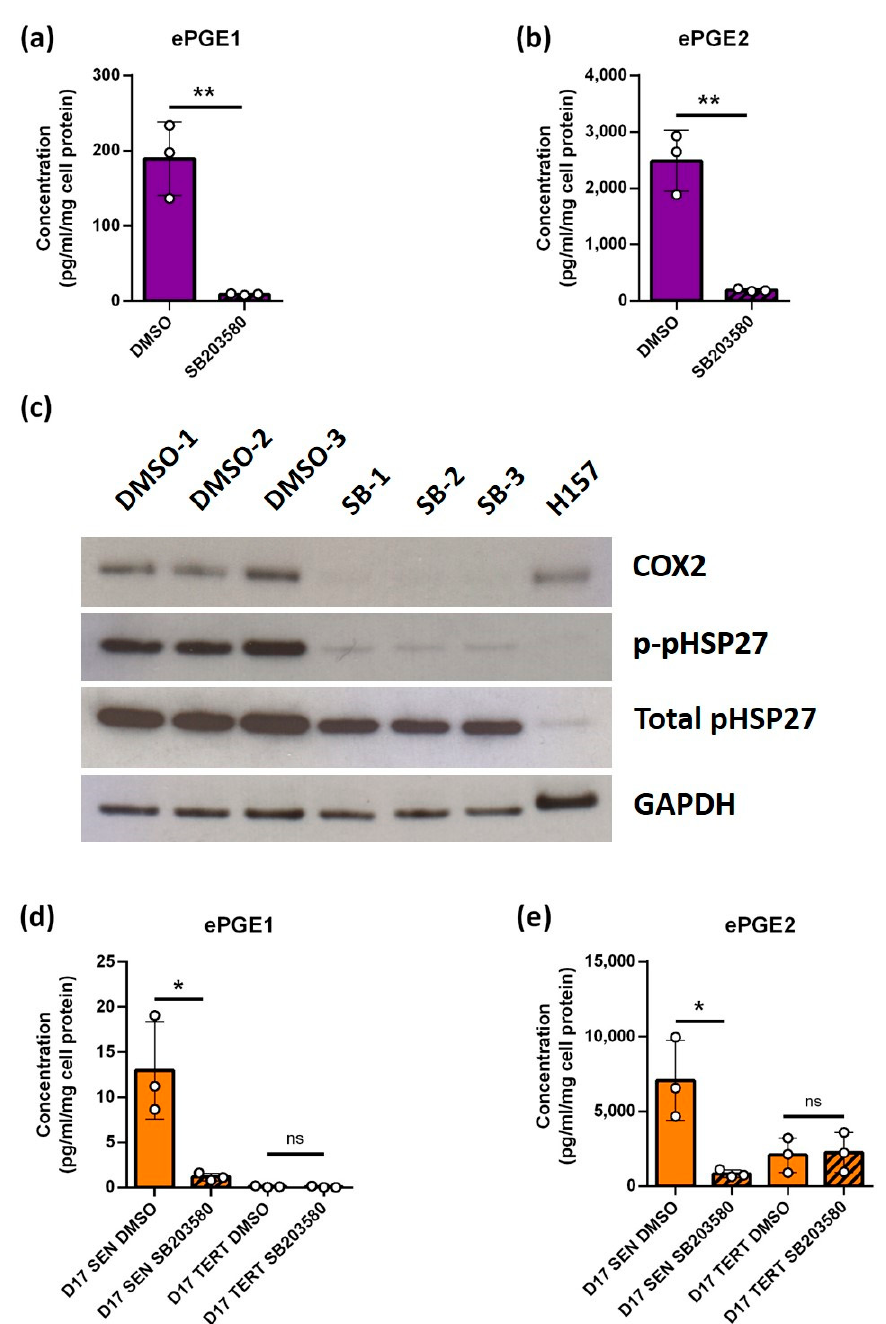
Figure 4. ePGE expression in OKF6 keratinocytes is mediated by p38MAPK. ( a , b ) show ePGE1 and ePGE2 levels in OKF6 cells treated with the p38MAPK inhibitor SB203580 (striped bar) along with the DMSO control (plain bar). The figure shows a dramatic reduction in ePGE1 ( a ) and ePGE2 ( b ) following treatment in 3 independent OKF6 cultures (+/ − standard deviation, ** p < 0.01 by Student’s unpaired t test. ( c ) shows representative Western blots of all three independent cultures indicating a dramatic reduction of COX-2 and heat shock protein (HSP-27) phosphorylation (p-pHSP-27) following treatment of OKF6 cells with SB203580 (SB 1-3). GAPDH was used as a loading control and H157 as a positive control for COX-2. ( d , e ) Show similar data from senescent D17 cells (D17SEN) and the same cells immortalized by ectopic expression of the catalytic subunit of telomerase TERT (D17 TERT) for ePGE1 ( d ) and ePGE2 ( e ). SB203580 (striped bars) inhibited both ePGEs in D17 SEN, * p < 0.05 by Student’s unpaired t test but had no effect in D17 TERT.